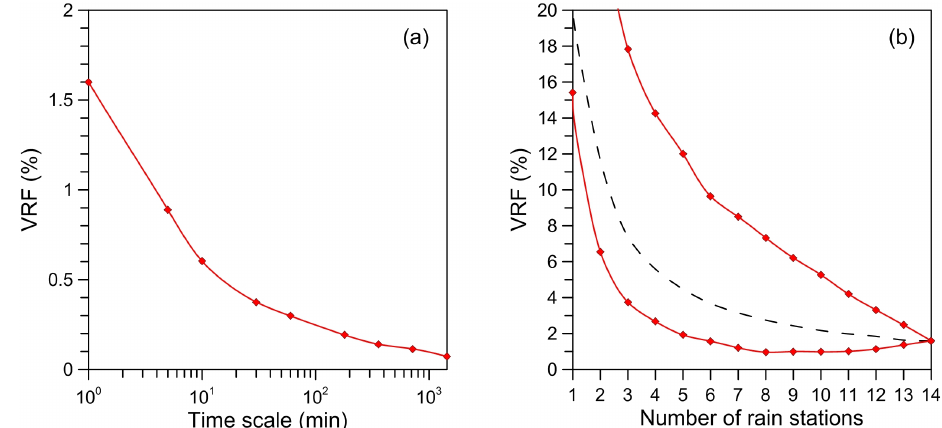
Fig. 5. Variance reduction factor (VRF) as a function of (a) timescale and (b) number of rain stations in the study area for the 1min timescale (maximum, minimum and